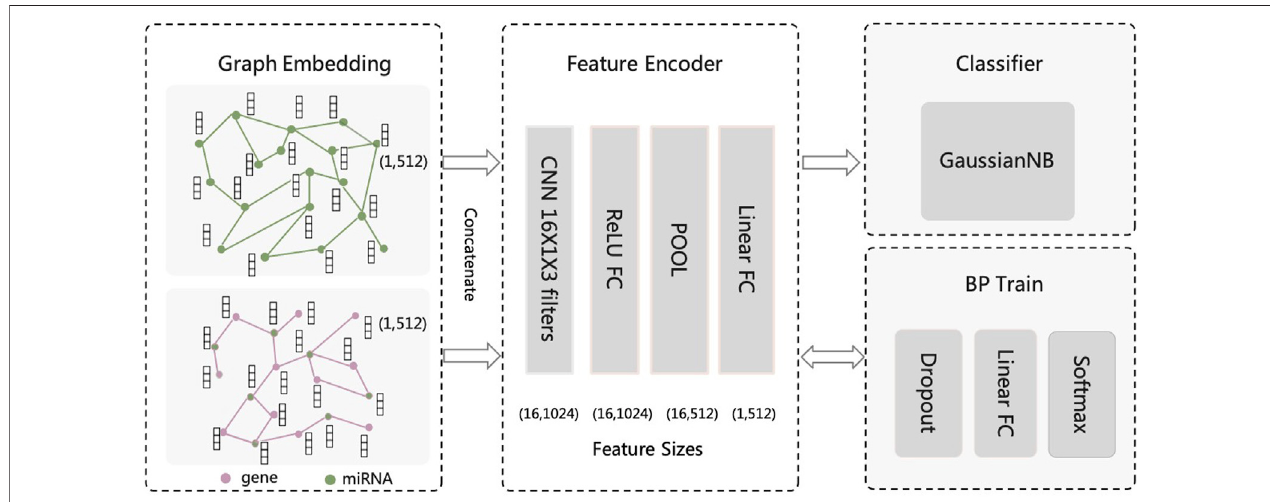
FIGURE 1 | The CNN-based computational framework for predicting miRNA associated with Multiple